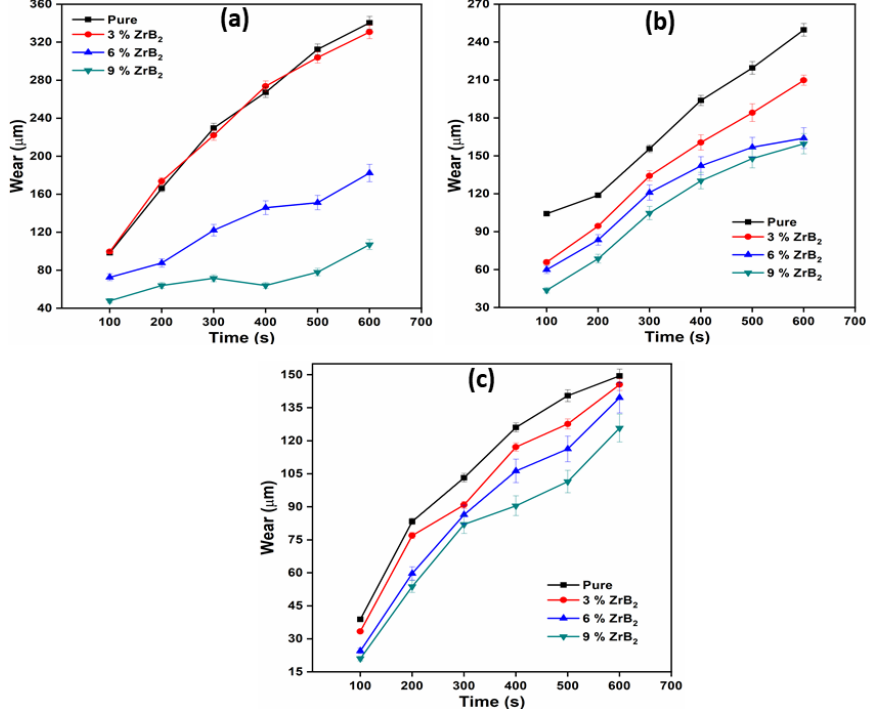
Figure 6. Variation of wear with time at 20N at ( a ) 600 RPM; ( b ) 400 RPM; ( c ) 200 RPM.